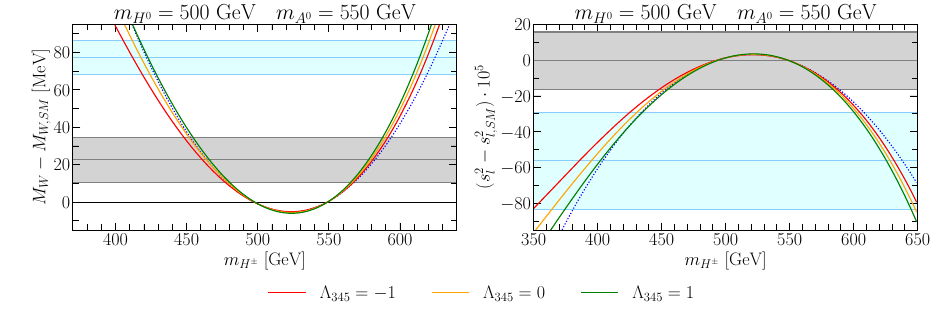
Fig. 4 Shift in M W and s 2 in the IHDM from neutral–charged Higgs current world averages with 1 σ range are displayed by the grey areas; l bosonmasssplitting,withone-loopnon-standardcorrectionsonly(blue the areas in light blue indicate the new CDF result for M W (left panel) dashed line) and including the non-standard two-loop corrections (full and the SLD result for s 2 lines). The different solid lines represent different values of (cid:10) 345 . The